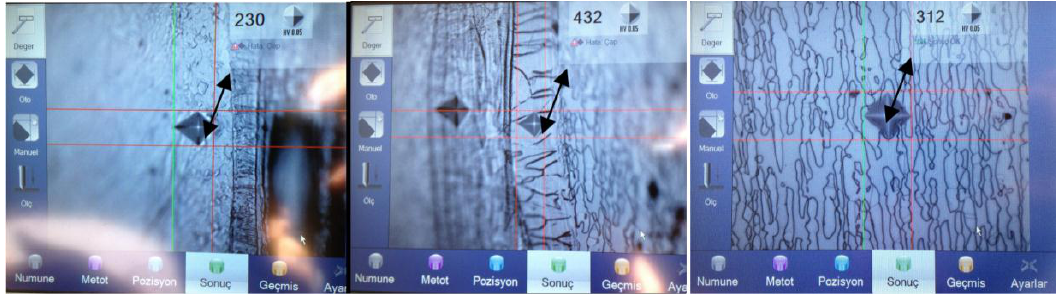
Figure 11. Micro Vickers hardness measurement screens of 1-140 V welded samples (1200×).